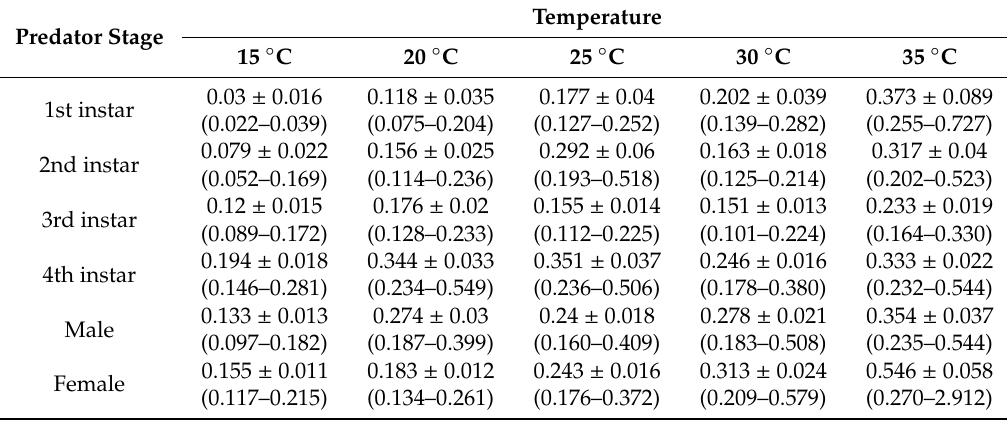
Table 4. Coe ffi cients of attack rate (mean ± SE) of Harmonia axyridis at various predatory stages and temperatures, preying upon Spodoptera litura eggs (according to Roger’s random predator